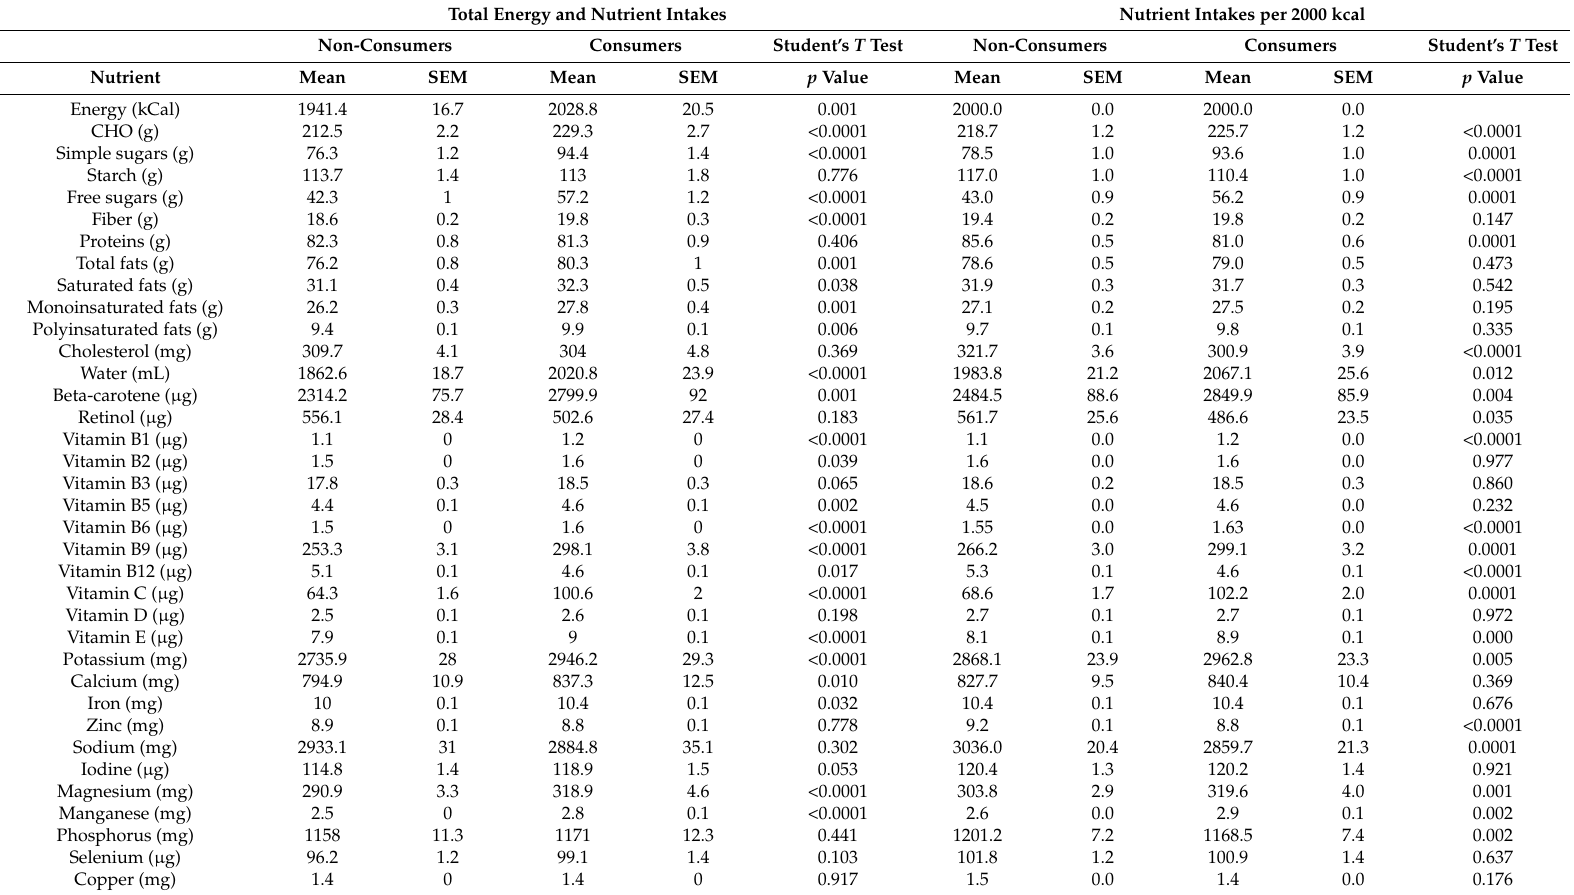
Table 2. Daily energy and nutrient intake in FJ consumers (weighted n = 773) and non-consumers (weighted n =